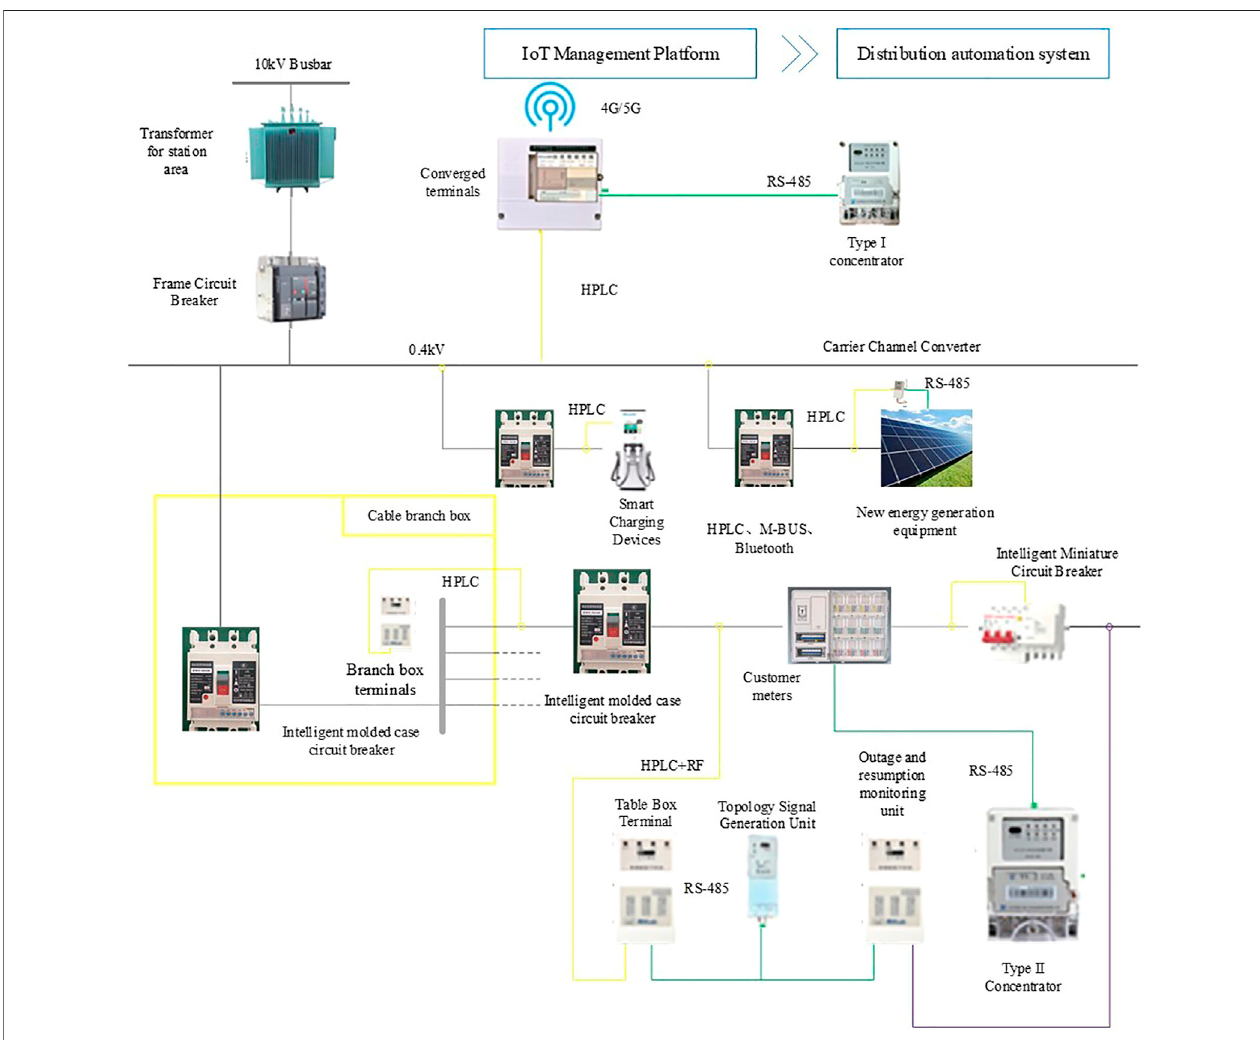
FIGURE 2 | Overall topology of the low-voltage